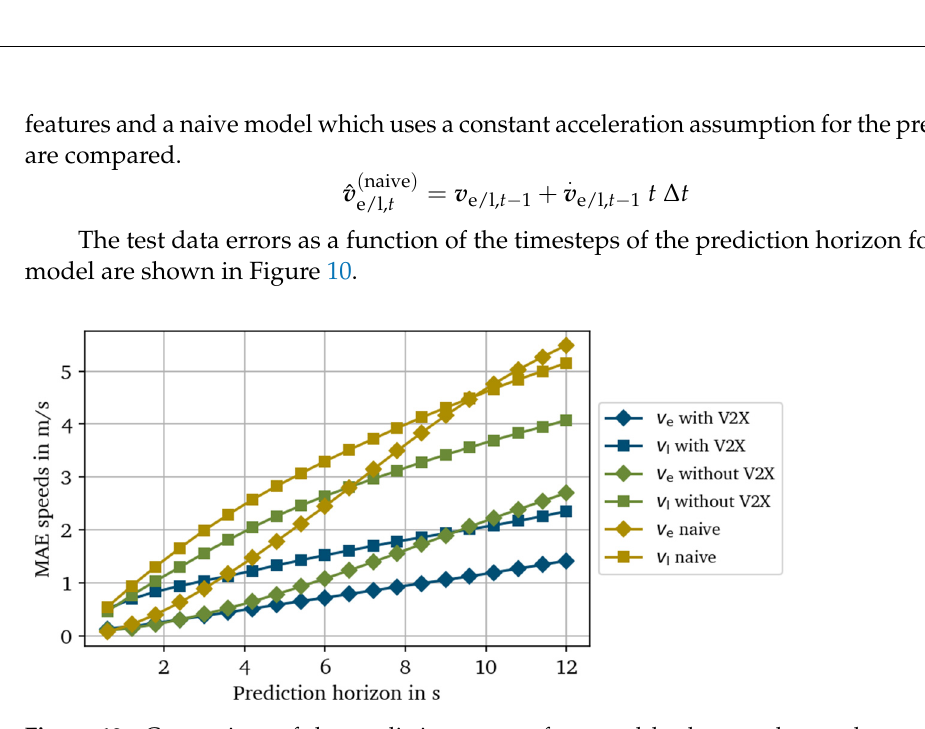
Figure 10. Comparison of the prediction errors of ego and leader speed 𝑣 (cid:2915) and 𝑣 (cid:2922) on the test data for the models with V2X features, without V2X features and a naive model with a constant acceleration assumption.